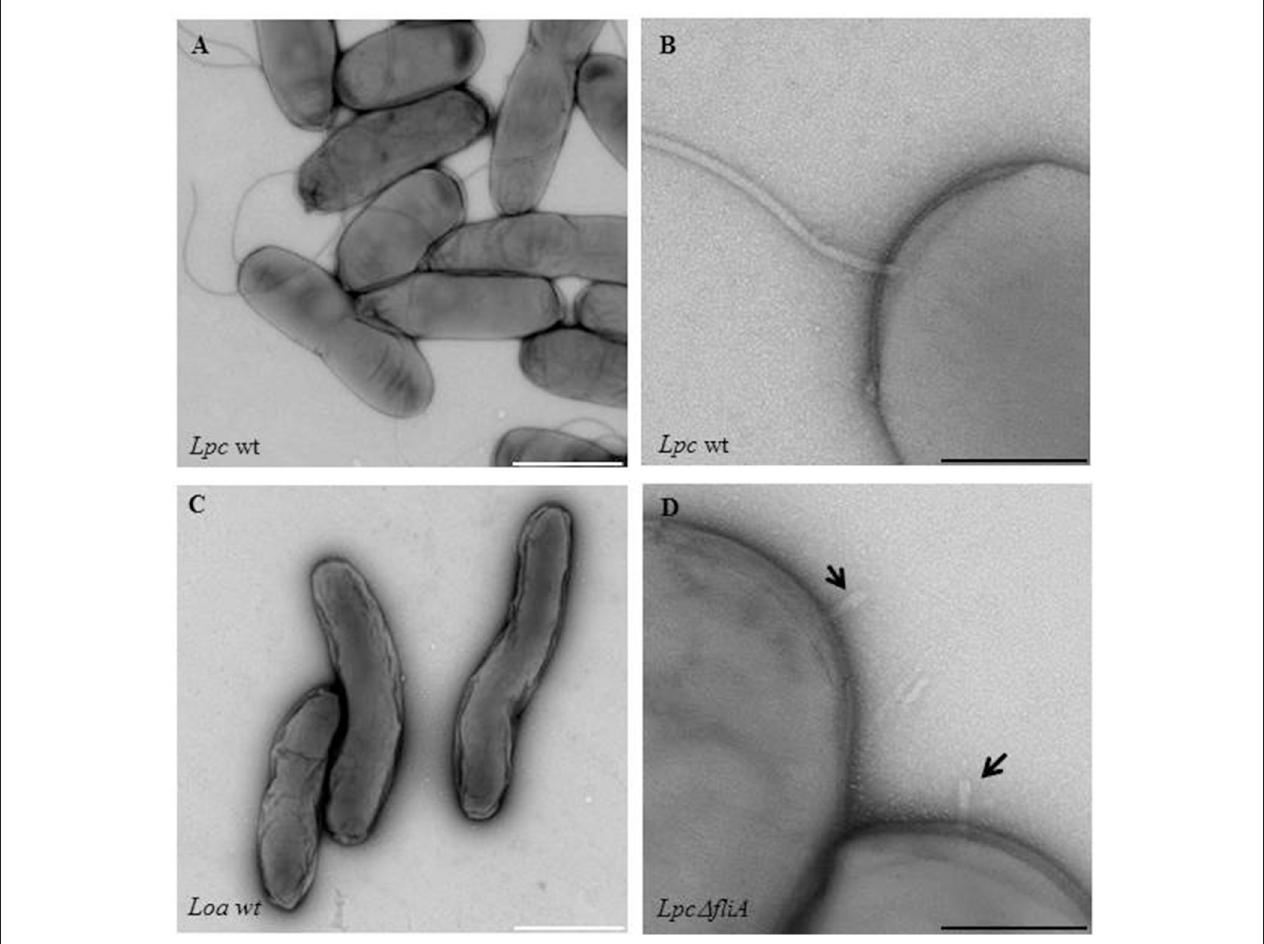
FIGURE 1 | Electron microscopic images of flagellated and non-flagellated Legionella wild-type strains as a flagella mutant strain. Shown are (A,B) Legionella pneumophila Corby (Lpc wt) and (C) Legionella oakridgensis (Loa wt) wild-type strains that are either representative of flagellated or non-flagellated Legionella . An electron microscopic image of a fliA L. pneumophila mutant strain (Lpc 1 fliA ), is also shown (D) . The straight hook structure of the mutant strain is indicated by black arrows (D) . Bacteria were grown in AYE medium at 30 ◦ C and the samples were stained with 0.5% uranyl acetate. White scale bars: 1 µ m; black scale bars: